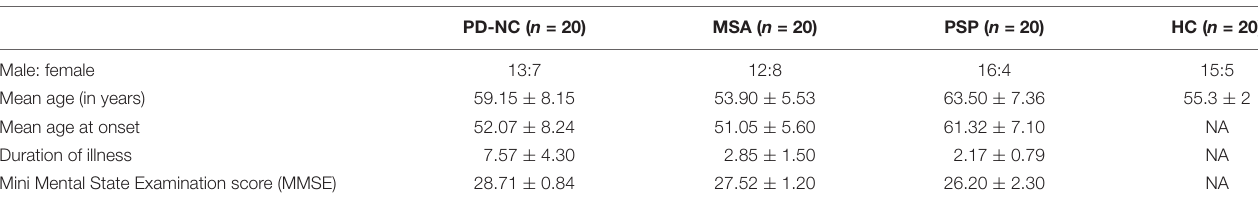
FIGURE 2 | Comparison of CC region in brain across samples taken from HC. PD, PSP, and MSA (A) MR image of HC. (B–D) MRI scans of subjects with PD. PSP and MSA respectively. Panel (F) shows the CC thickness centile profile for all study groups: HC (blue)-blue, PD-NC (black). MSA (red), PSP (green). The centiles are plotted along x -axis. The thickness profile clearly shows the thickness reduction in CC occurred in Parkinsonian disorders compared to HC. The zoomed version of (i) manually extracted CC from mid-sagittal MRI and (ii) the extracted ROIs within CC are also shown in the left most column. ROI (the overlapping rectangular boxes of size 5 × 5 shown in red all through the CC) automation with window size 5 × 5 ensures the entire CC is exhaustively covered. Some sample ROIs are highlighted in blue. TABLE 1 | Demographic details of patients and